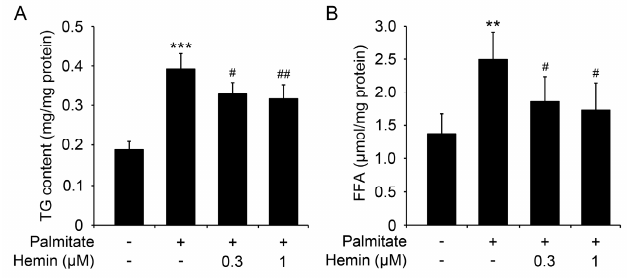
Figure 2. Hemin diminishes triglyceride accumulation and increases free fatty acid content in mouse primary hepatocytes induced by palmitate. Mouse primary hepatocytes were treated with hemin at the indicated concentration for 6 h, and then palmitate was added at a final concentration of 0.6 mM to induce the accumulation of triglyceride (TG) and increase of free fatty acid (FFA) for 18 h. Subsequently, the cells were harvested to measure cellular triglyceride ( A ) and free fatty acid ( B ). ** p < 0.01; *** p < 0.001 versus hepatocytes without treatment of palmitate and hemin; # p < 0.05; ## p < 0.01 versus hepatocytes treated with palmitate but without hemin.